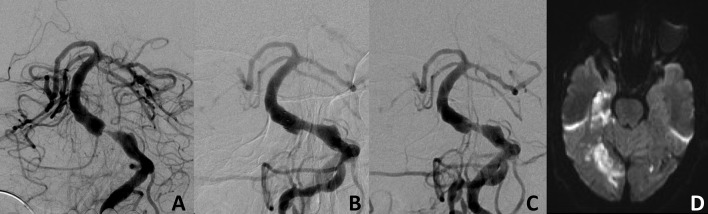
Basilar artery stenosis at the level of the origin of the anterior inferior cerebellar artery before (A) and after (B) Stent-PTA treatment. In-stent thrombosis after discontinuation of double antiplatelet therapy 4 months after treatment (C) with multiple embolic infarcts in the territories of both posterior cerebral arteries (D).